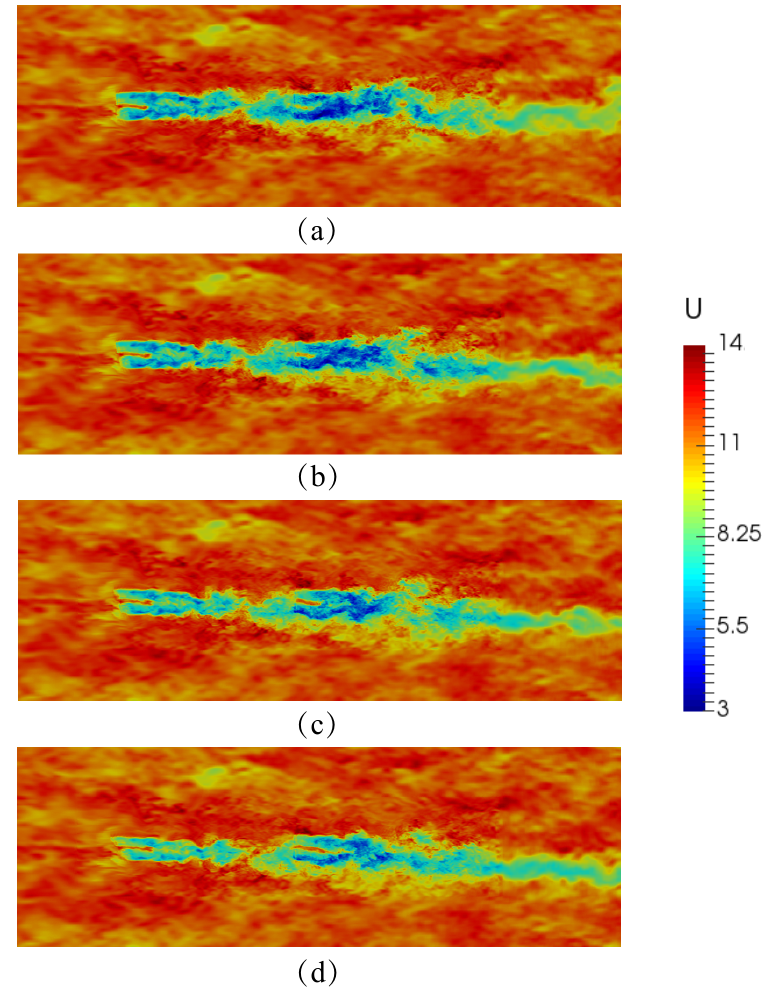
Figure 17. Contours of instantaneous velocity in the horizontal plane at hub height: ( a ) yaw = 0 ◦ ; ( b ) yaw = 10 ◦ ; ( c ) yaw = 20 ◦ ; ( d ) yaw = 30 ◦